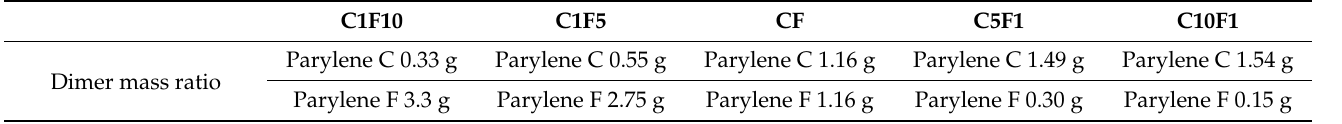
Table 1. Dimer mass ratio control of the Parylene C and Parylene F